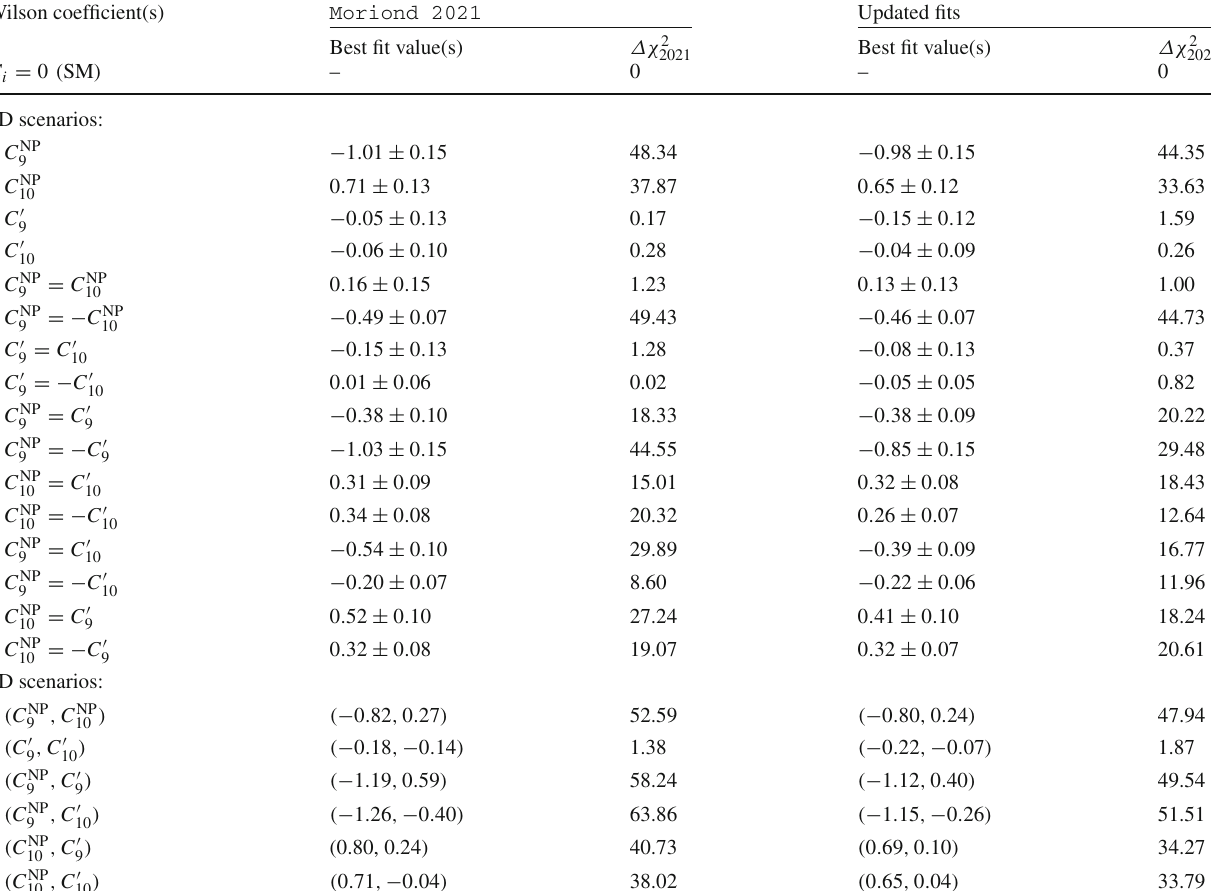
≈ 199 (200) for Moriond 2021 (updated fits) data SM